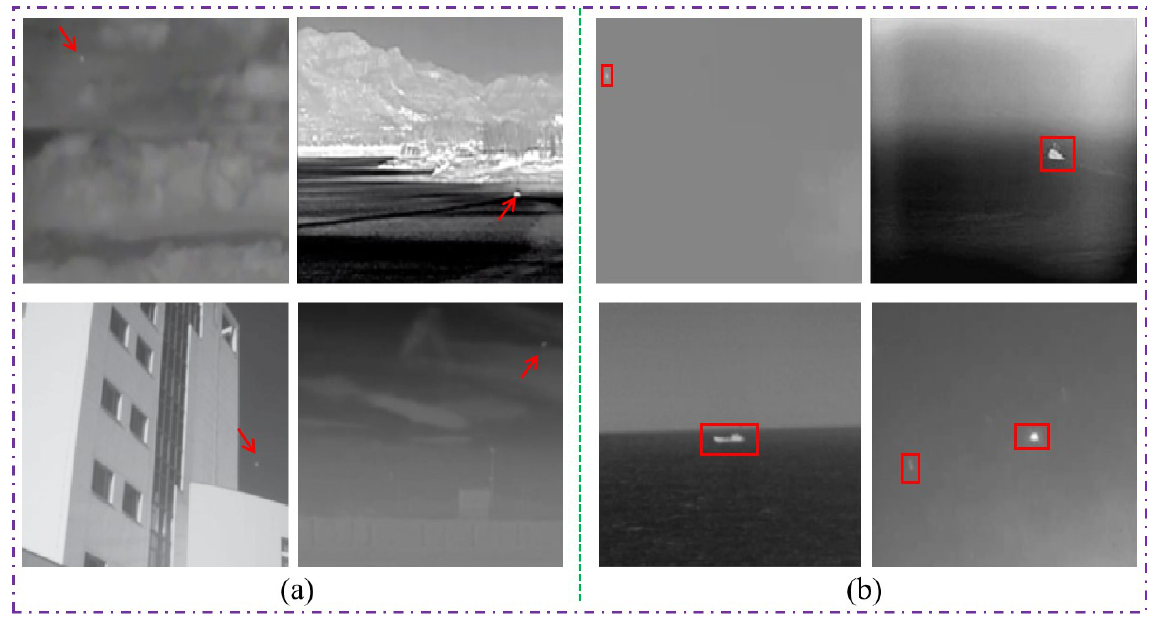
Figure 1. Examples of small infrared targets. ( a ) Small targets submerged in complex environments, as indicated by the red arrows. ( b ) Small targets of different scales, as indicated by the red